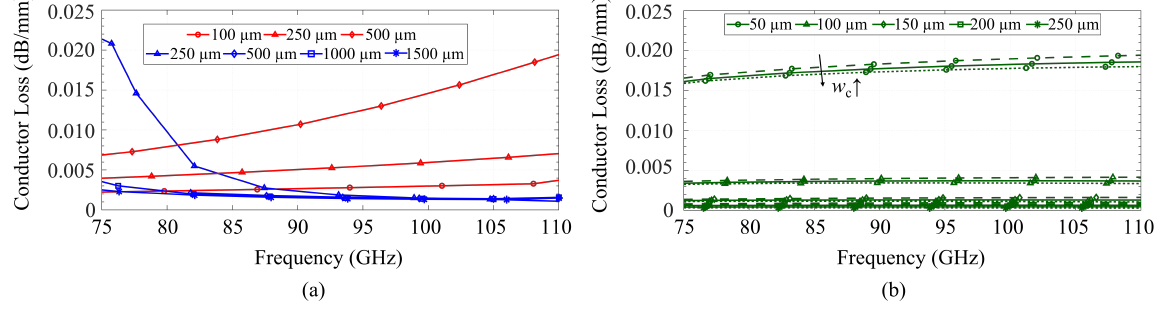
Figure 11. Conductor loss associated with ( a ) the back metallization and ( b ) top encapsulation. Aluminum is considered in every case. Red: CB-CPW. Blue: GapCPW. Green: IGCPW. Channel width in ( b ) is represented by dashed lines (350 µ m), solid lines (450 µ m) and dotted lines (550 µ